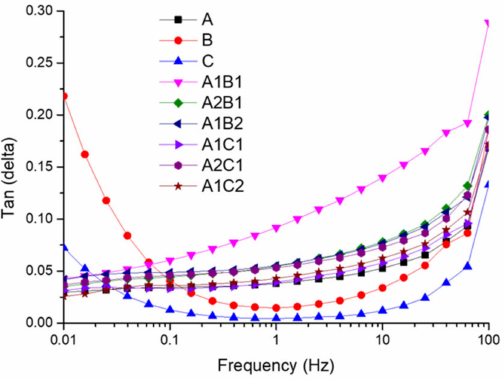
Figure 8. Low shear linear viscoelastic rheology of reference samples and the IPNs. The elastomers obtained based on networks A, B, and C are soft with low tensile stresses and moderate elongations at break dictated by the molecular weights and the chosen cross-linking type. The long dangling chains emphasized by low shear linear viscoelastic rheology act as a plasticizer and give to sample B the lowest stress (0.1 MPa) and the highest elongation at break (330%), with a low value of Young’s modulus (calculated at 5% strain, 0.24 MPa). With a lower molecular weight of the vinyl terminated PDMS, the plasticizer effect is less pronounced, as in case of Sample C, having a decreased elongation at break (106%) and an increased Young’s modulus (0.47 MPa). The mechanical properties of the IPNs are drastically influenced by the presence of the rigid networks. The rigid network B acts as reinforcing agent, and the AxBy series have increased tensile stress and slightly decreased elongations at break (Figure 9, Table S4) compared to reference samples. Using a rigid network with a lower molecular weight (C), AxCy series have the highest tensile stress (1.74 MPa) and reach elongation at break more than twice compared to starting networks (720%). Moreover, the yield strength of both series (which denotes the elastic limit of the stress-strain curves) shifts to maximum elongation at break.